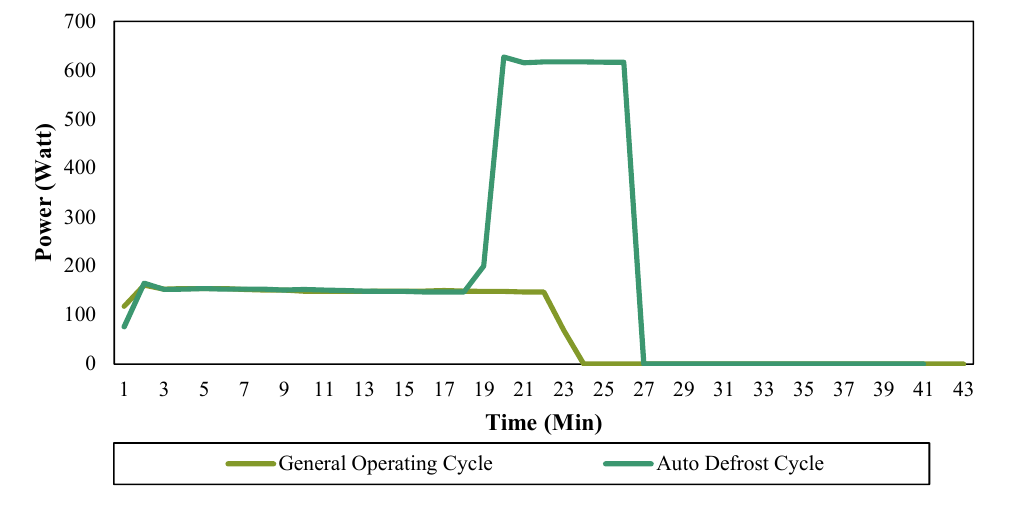
Figure 3. General operating cycle vs. auto defrost